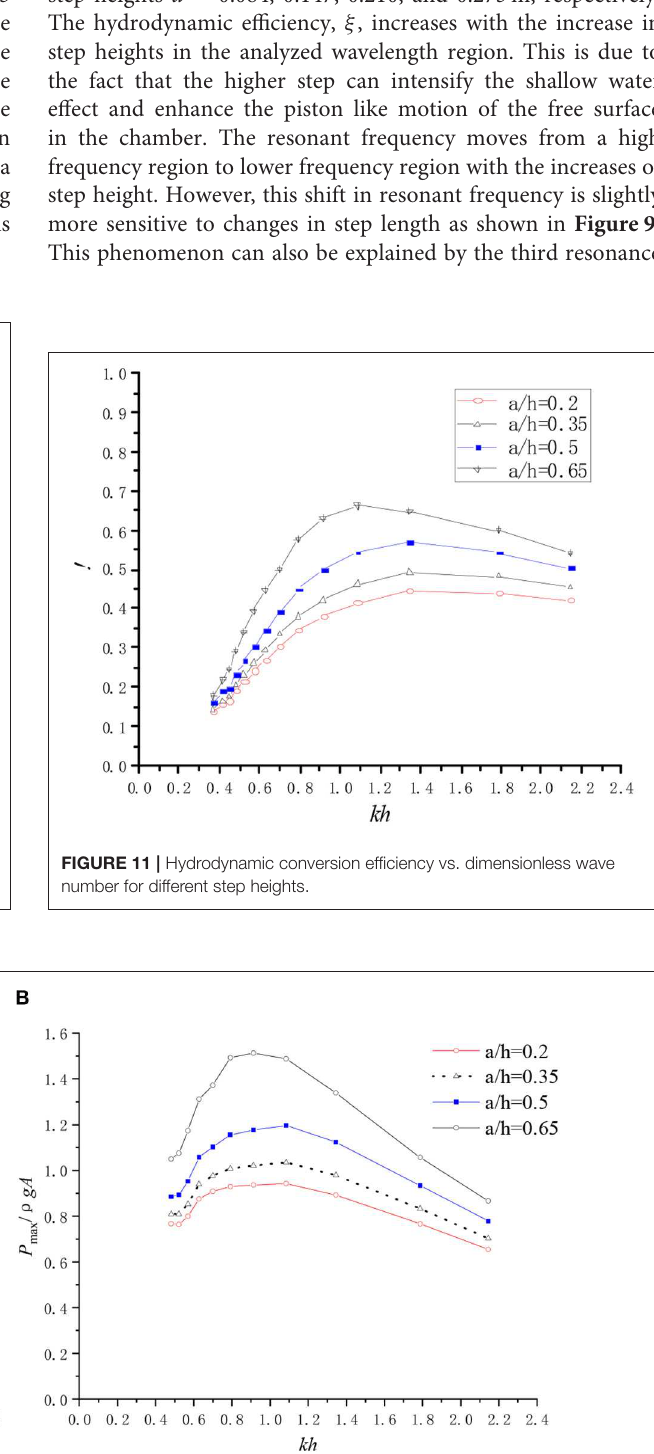
FIGURE 10 | (A) The surface elevation crest. (B) The air pressure crest for different step